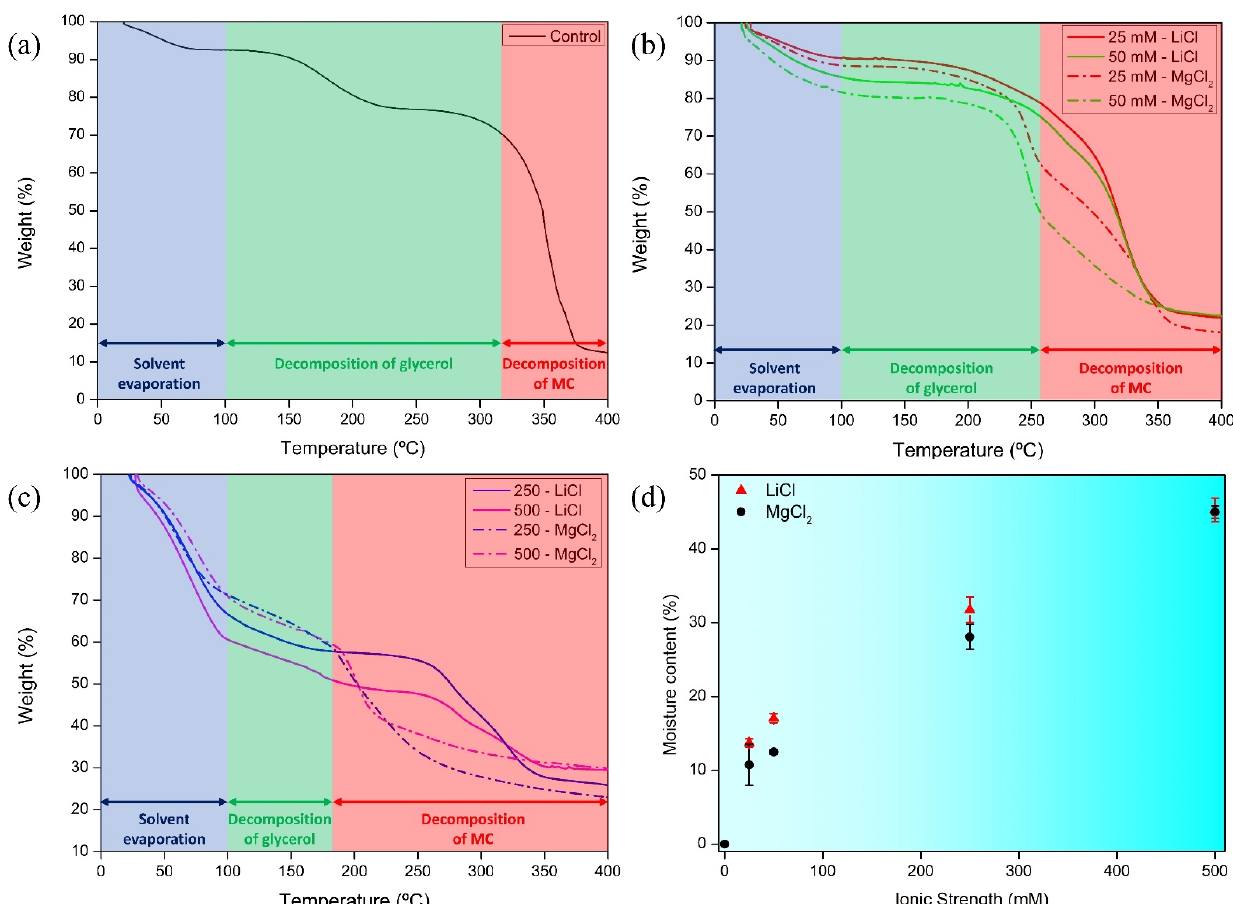
Figure 3. Thermal decomposition of MC-based films with 0 ( a ), 25, 50 ( b ) and 250, 500 mM ( c ) due to LiCl or MgCl 2 addition. Moisture content of the MC-based films prepared at different IS (0; 25; 50; 250, and 500 mM) corrected with addition of LiCl or MgCl 2 ( d ).